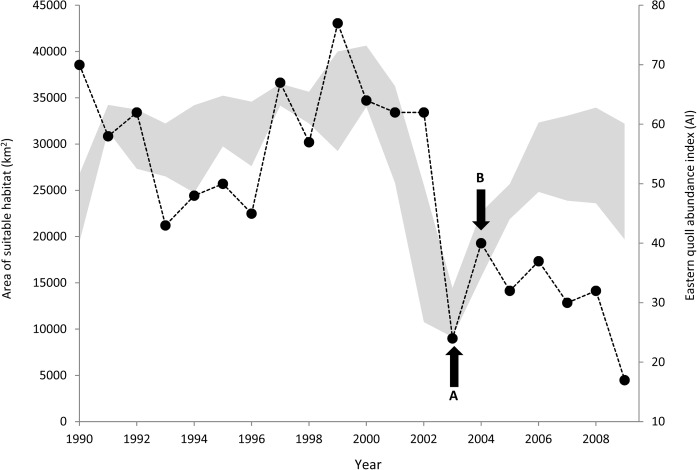
Temporal variation in area of environmentally suitable habitat and quoll abundance from 1990 to 2009.Grey shading represents the total area of core habitat across all 12 months for each year (left axis) as given by the independent binary weather model. Width of shading indicates variability of suitable area within each year (lower and upper bounds of shading represent the months with the lowest and highest amounts of suitable habitat respectively). Black dots represent the quoll abundance index (AI), being the total number of eastern quoll sightings recorded in annual spotlight surveys across all transects (n = 147) surveyed every year from 1990 to 2009 inclusive (right axis) [7]. Arrows indicate (A) identified changepoint in mean quoll AI, and (B) identified changepoint in relationship between area of suitable habitat and quoll AI.